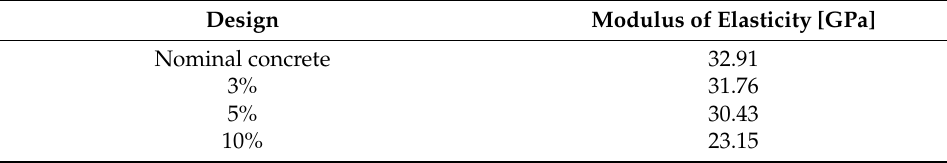
Table 5. Results of the modulus of elasticity test.